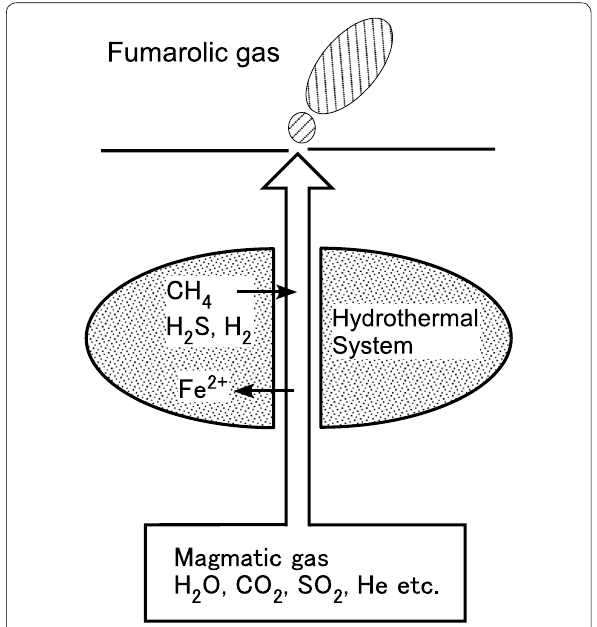
Fig. 7 Flow of magmatic gas and the entrainment of hydrothermal components